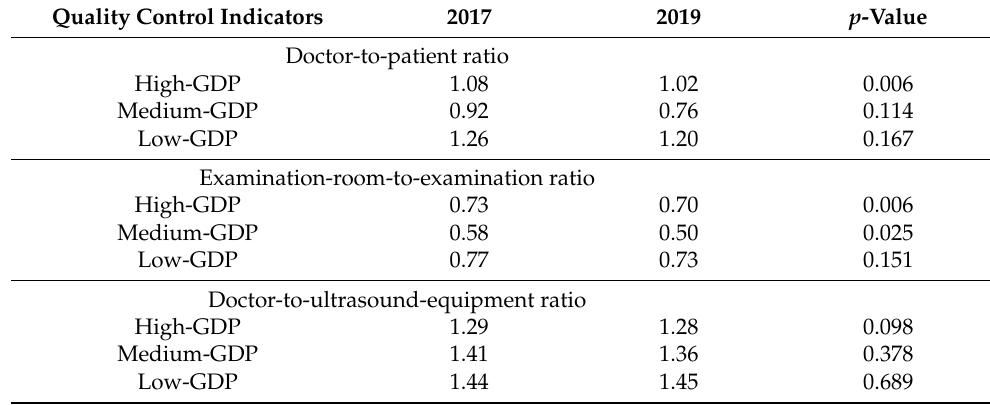
Table 4. Performance in quality control indicators of high-GDP, medium-GDP, and low-GDP provinces. Quality Control